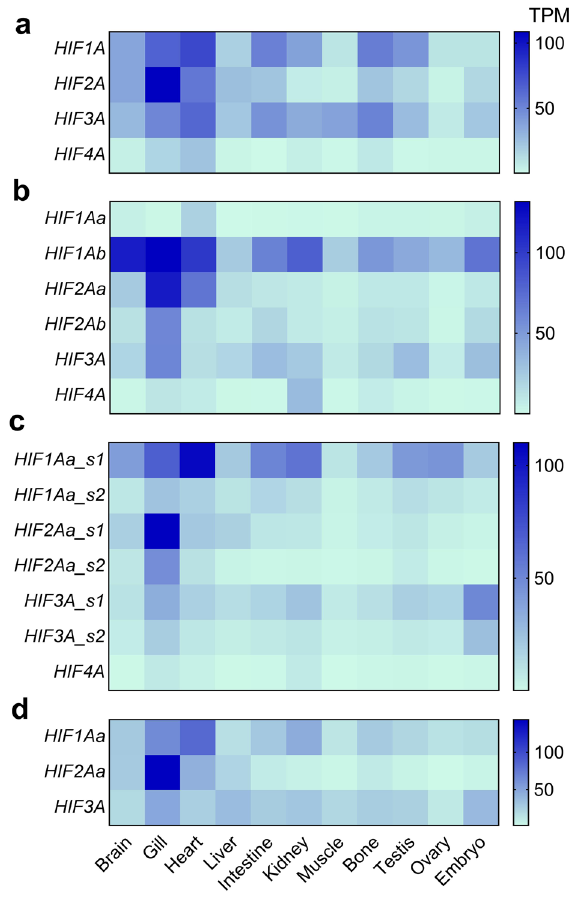
each HIFA : silver arowana ( Osteoglossum bicirrhosum ), bowfin ( Amia calva ), European eel ( Anguilla anguilla ), Northern pike ( Esox lucius ), Eastern mudminnow ( Umbra pygmae ), ( b ) HIFA transcript abundance (in TPM) in Otocephala: Allis shad ( Alosa alosa ), zebrafish ( Danio rerio ), panga ( Pangasius hypophthalmus ), and Mexican tetra ( Astyanax mexicanus ); ( c ) HIFA transcript abundance (in TPM) in Salmoniformes: grayling ( Thymallus thymallus ), European whitefish ( Coregonus lavaretus ), brown trout ( Salmo trutta ), rainbow trout ( Onchorhynchus mykiss) , and brook trout ( Salvelinus fontinalis ); ( d ) HIFA transcript abundance (in TPM) in species lacking HIF4A : Ayu sweetfish ( Plecoglossus altivelis ), Atlantic cod ( Gadus morhua ), medaka ( Oryzias latipes ), and European perch ( Perca fluviatilis ). The heatmap is based upon median TPM for a given paralog in each tissue (see Supplemental Table S4 for tissue-specific TPM values for each